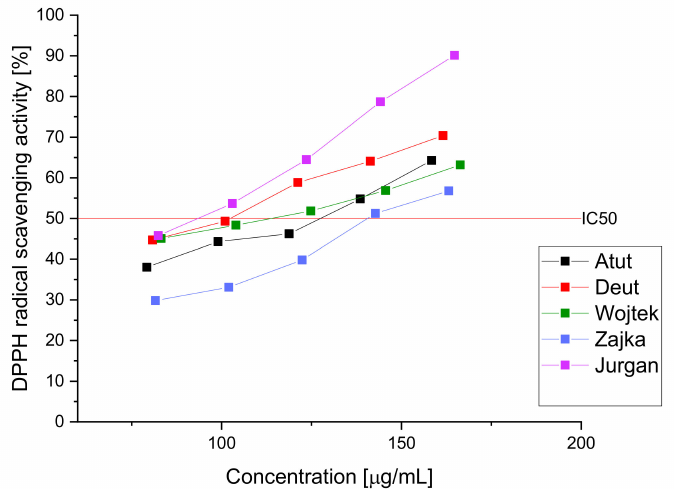
Figure 4. DPPH radical scavenging activity of aqueous extracts of haskap berry leaves.